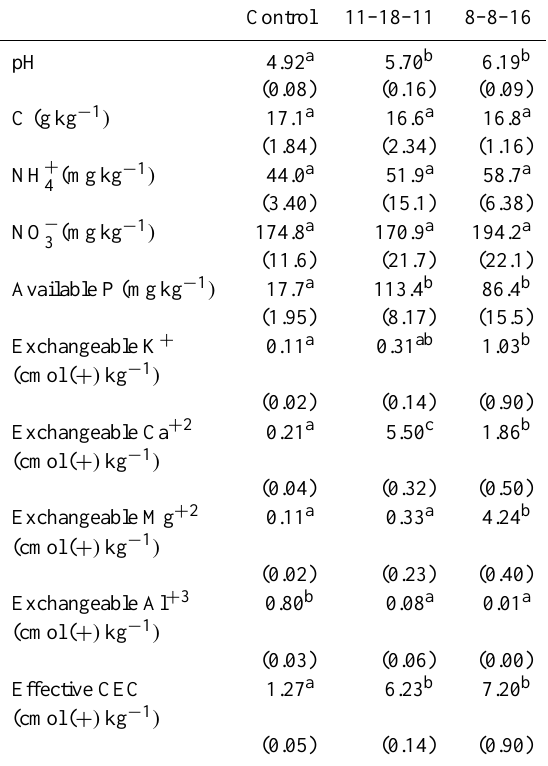
Table 3. Soil physicochemical properties at the end of the incuba- tion in soils under the different treatments (average of three repli- cates, with standard deviation in parentheses).